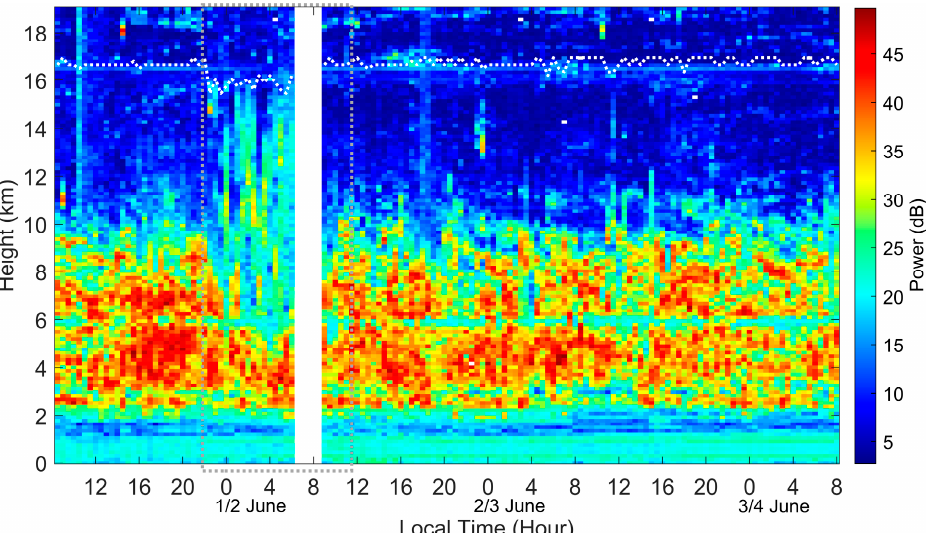
Figure 4. Echo power recorded by the vertical beam of the Wuhan MST radar from 8:00 LT on 1 June to 8:00 LT on 4 June 2015. The tropopause height variation measured by the radar is shown by the white dotted curve. The gray box indicates the duration of the anomalous echoes as well as the tropopause descent. The gap indicates the missing data at that time.